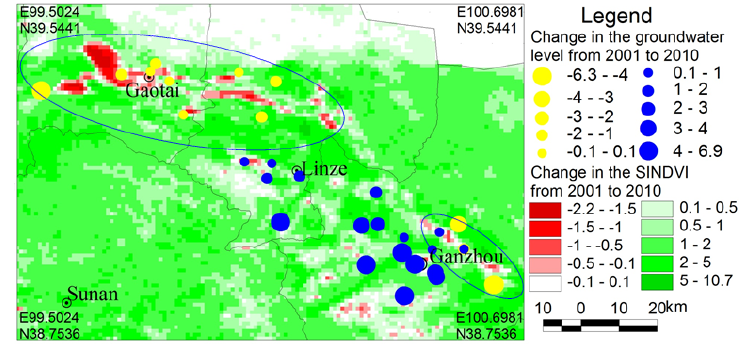
Figure 9. The dynamics of vegetation coverage and groundwater level change in the HRB.